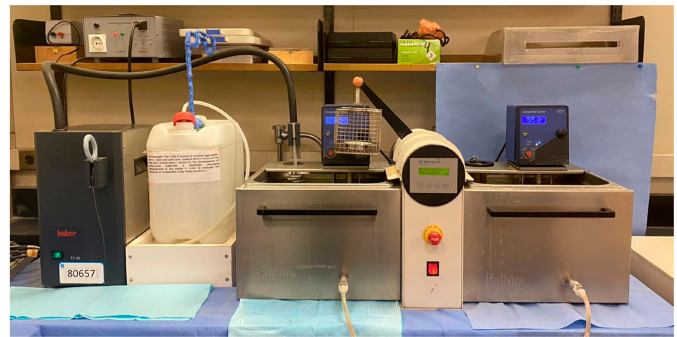
Figure 3. Thermocycler 1100 (SD-Mechatronik, Westerham, Germany).